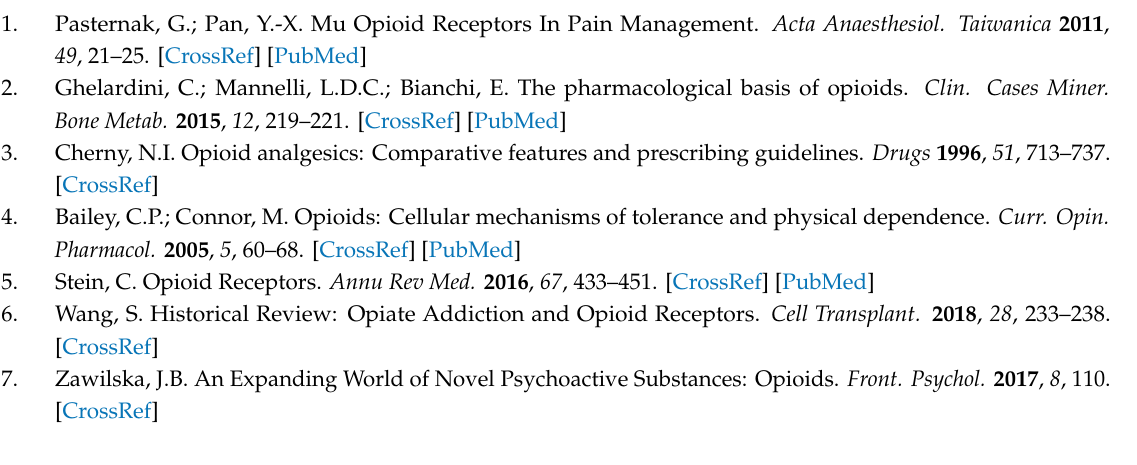
Table S1: List of primers used in the study. Table S2: Overview of the functionality of constructs used in the study using various assays and